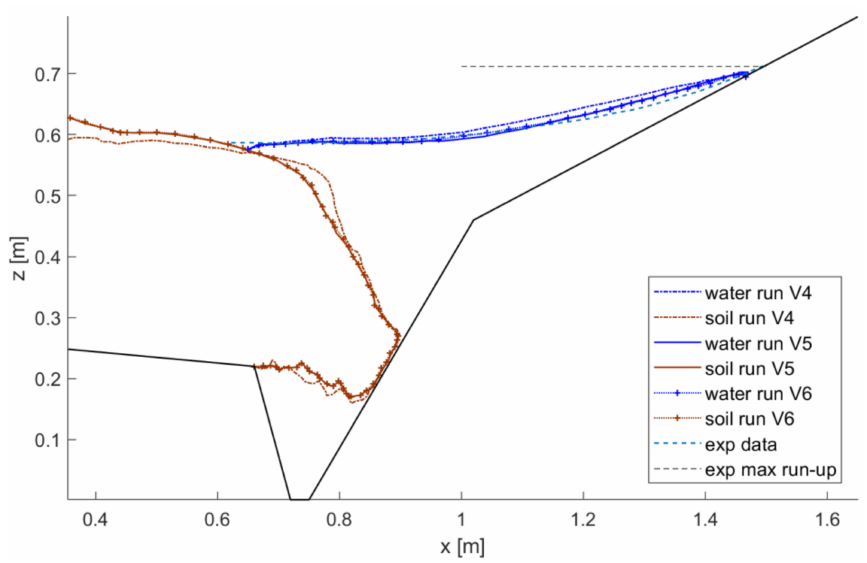
Figure 11. Comparison of maximum simulated run-up at t = 1.35 s for changes in spatial resolution dx . The calculated values of the absolute percentage error ∆ η % are also reported in Table 5: for the investigated range of coarser resolutions the results show that, to obtain analogous values of ∆ η % that are of the same order of the permitted error in the estimate of maximum run-up, the parameter µ 0 should be varied almost linearly with respect to the particle resolution dx